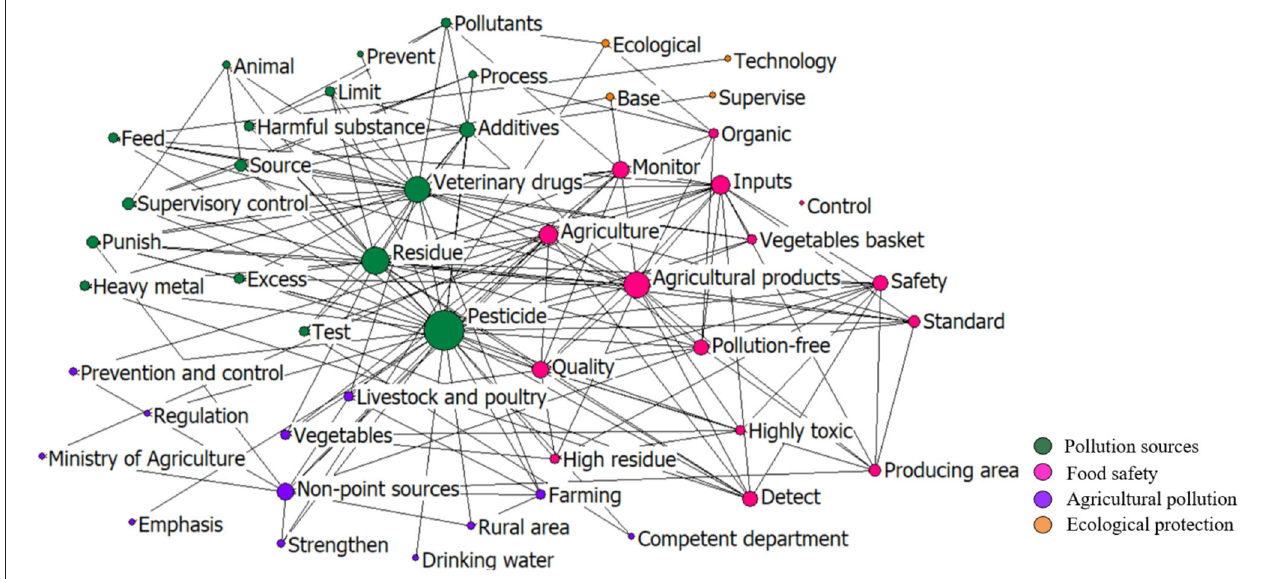
FIGURE 12 | The co-word network of the keywords in the policies in 1995–2005.